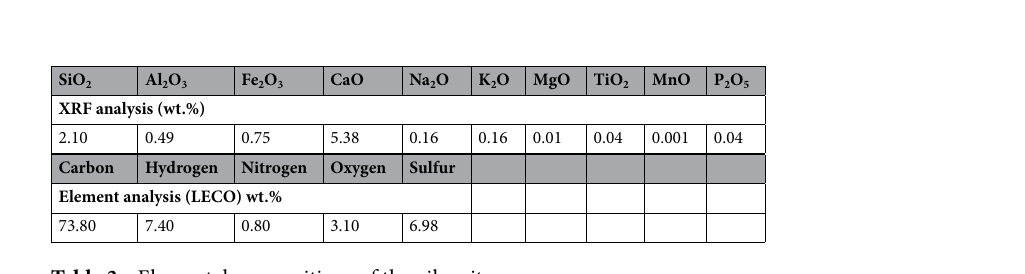
Table 3. Elemental compositions of the